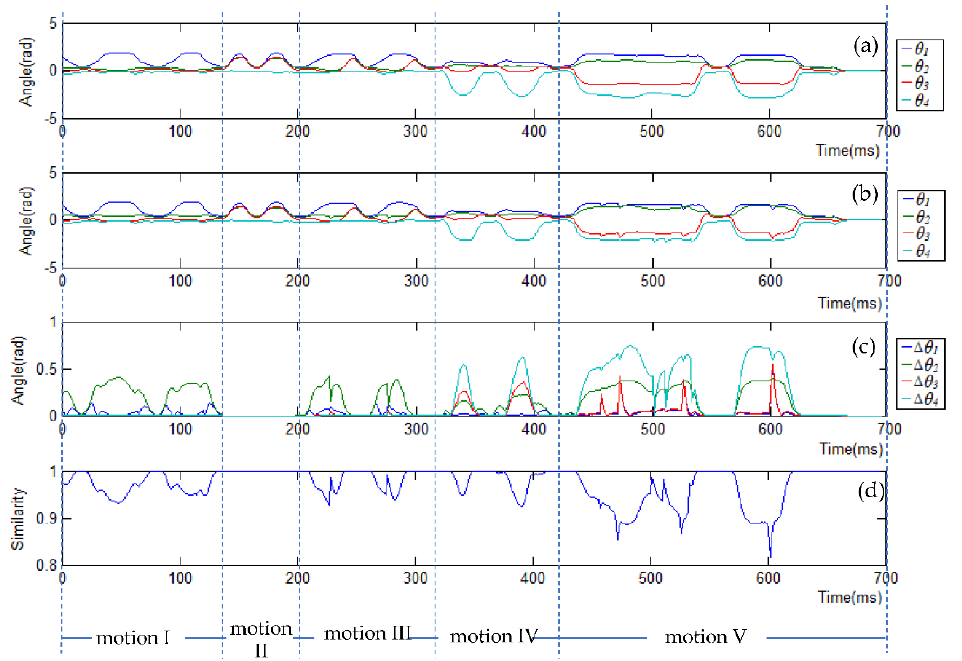
Figure 12. The trajectories of the left arm joint: ( a ) the trajectories of the four angles of the arm without self-collision avoidance; ( b ) collision-free trajectories of the arm; ( c ) the absolute angle difference between the trajectories in ( a , b ); ( d ) the similarity between ( a ) and ( b ).